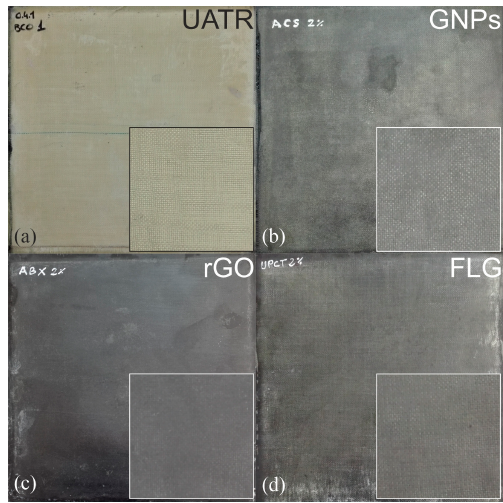
Figure 5. Force–displacement curves for tensile (left) and flexural (right) tests.